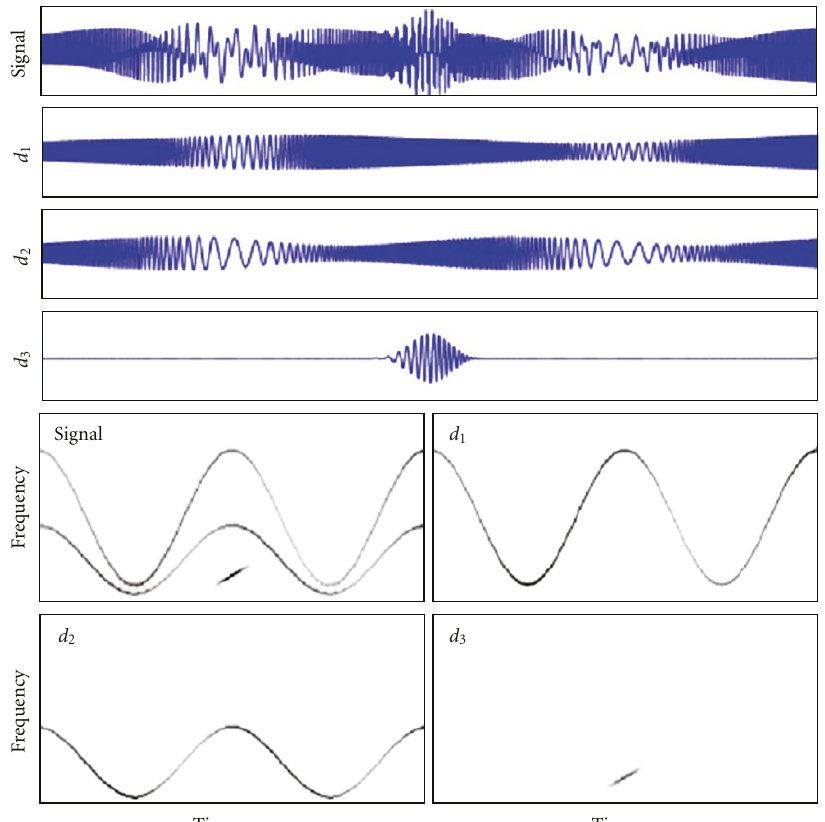
Figure 27: Synthetic three-component example. The signal in the top row is decomposed by the EMD, resulting in the three IMFs listed below. All TFDs are reassigned spectrograms (adopted from